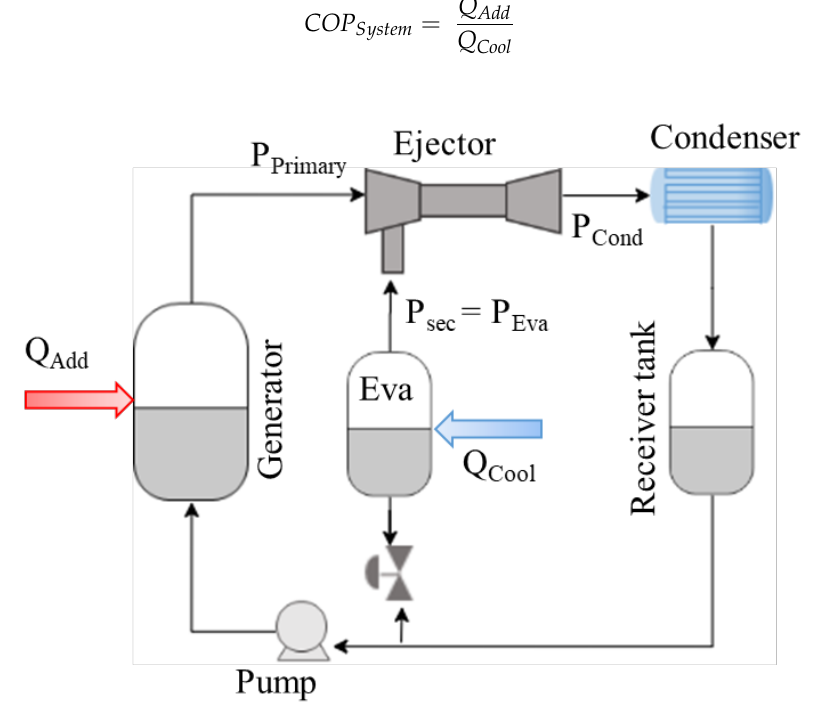
Figure 12. Validation of empirical correlation.